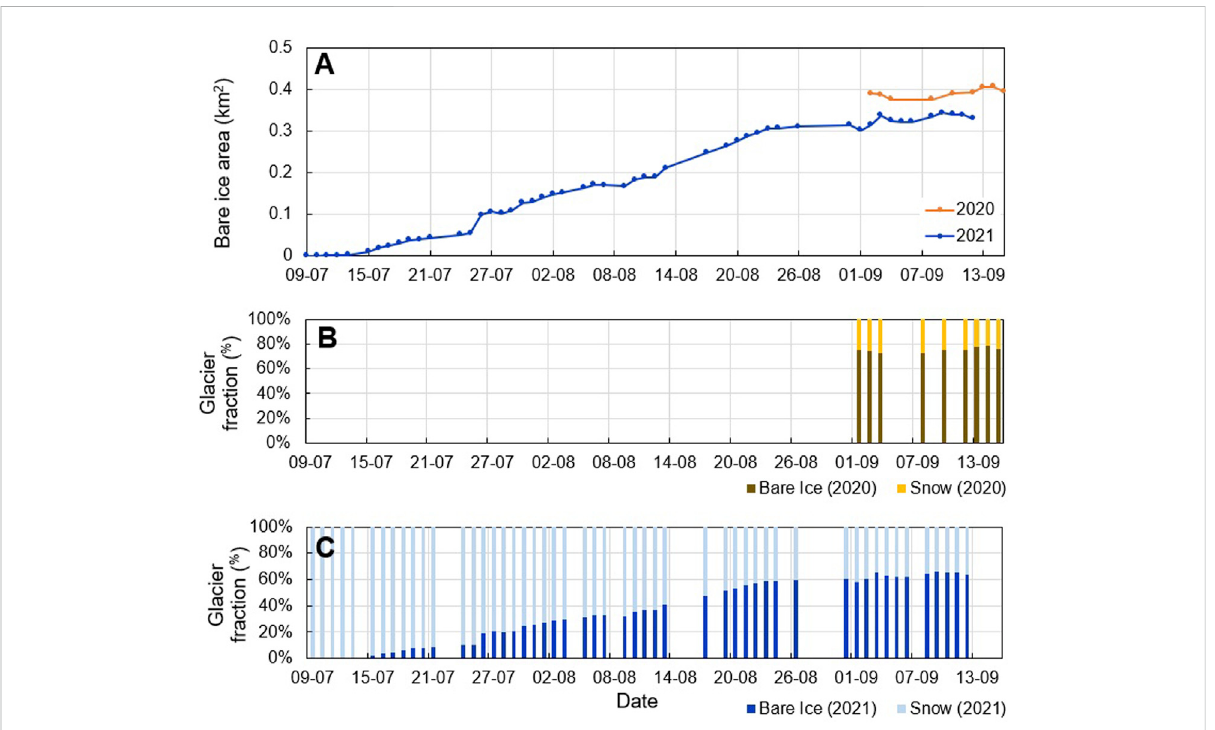
FIGURE 3 Evolutionofbare-iceareaduring2020and2021 (A) andfractionofQAScoveredbybareiceandsnowduringthe2020 (B) and2021 (C) summer melt seasons, derived from manually-delineated polygons in PyTrx. Bare ice and snow-cover areas have been calculated relative to the total area of QAS visible by the camera viewshed. Note in 2021 that bare ice area and bare ice/snow fractions up until 12th September 2021 are shown, which is the last date before several light snowfall events partially cover the bare ice. Melting then continues until 28th October (Figure